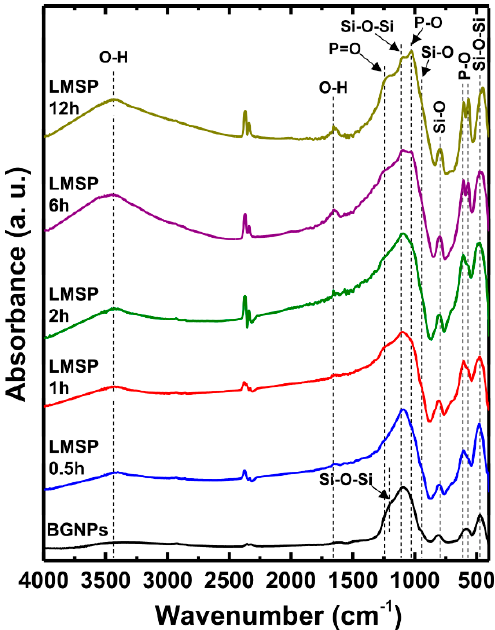
Figure 6. FT-IR spectra of BGNPs and LMSP samples in order of the sintering times from 0.5 to 12 h.